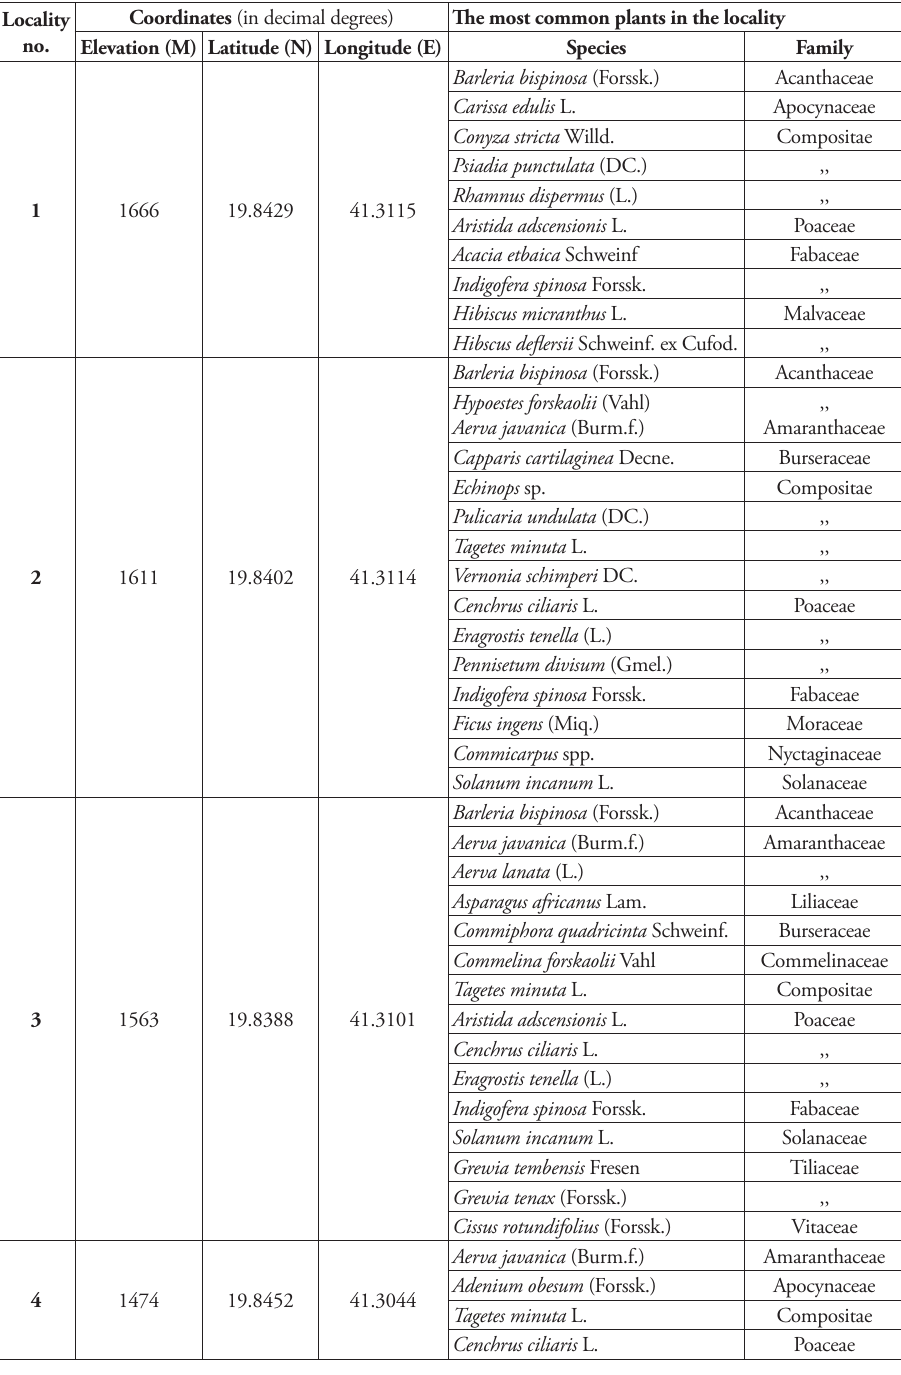
Table 1. An overview of the collecting localities with their coordinates and common vegetation. Coordinates (in decimal degrees) The most common plants in the locality Locality no. Elevation (M) Latitude (N) Longitude